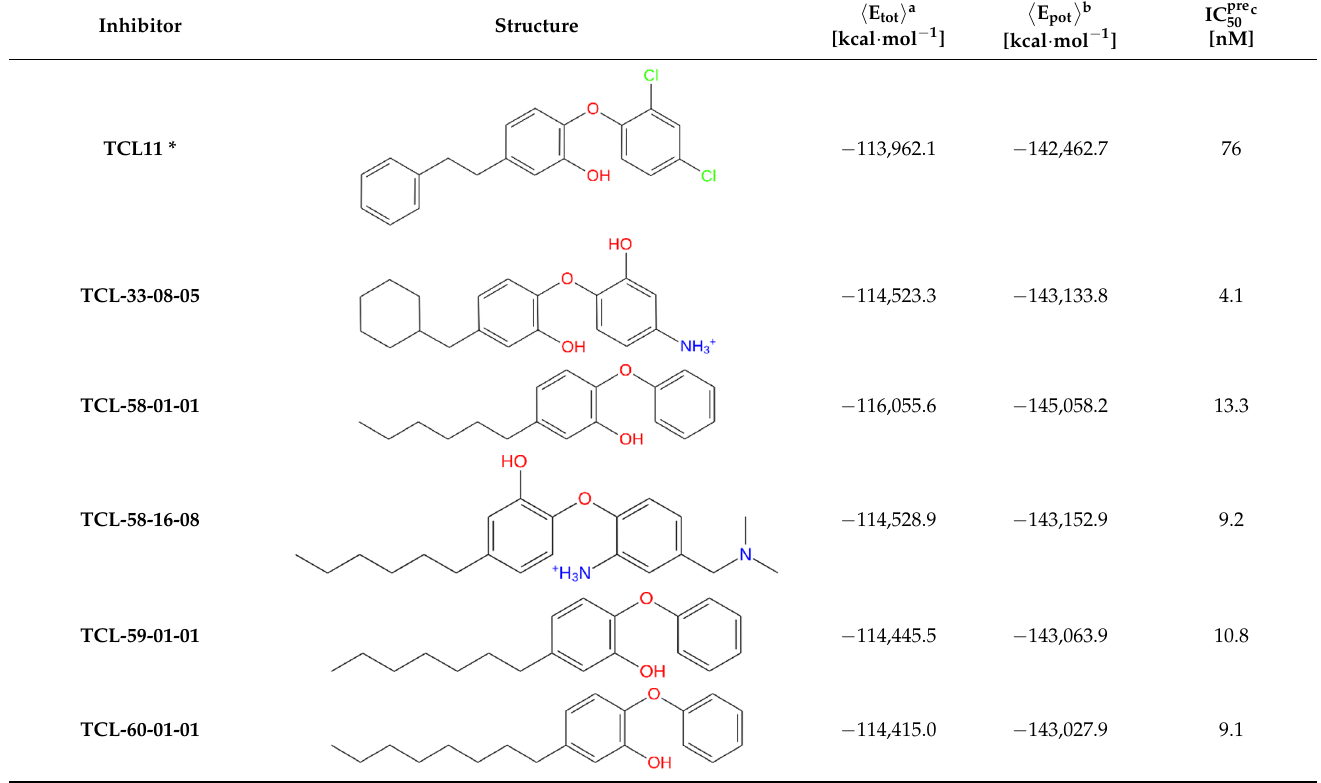
(Table 3, Equation (2)) for the designed analogues. Experimental IC (cid:2873)(cid:2868)(cid:2915)(cid:2934)(cid:2926) for the TCL11 . * TCL11 is the co ‐ crystallized ligand in the (PDB entry 1OOS) [21].